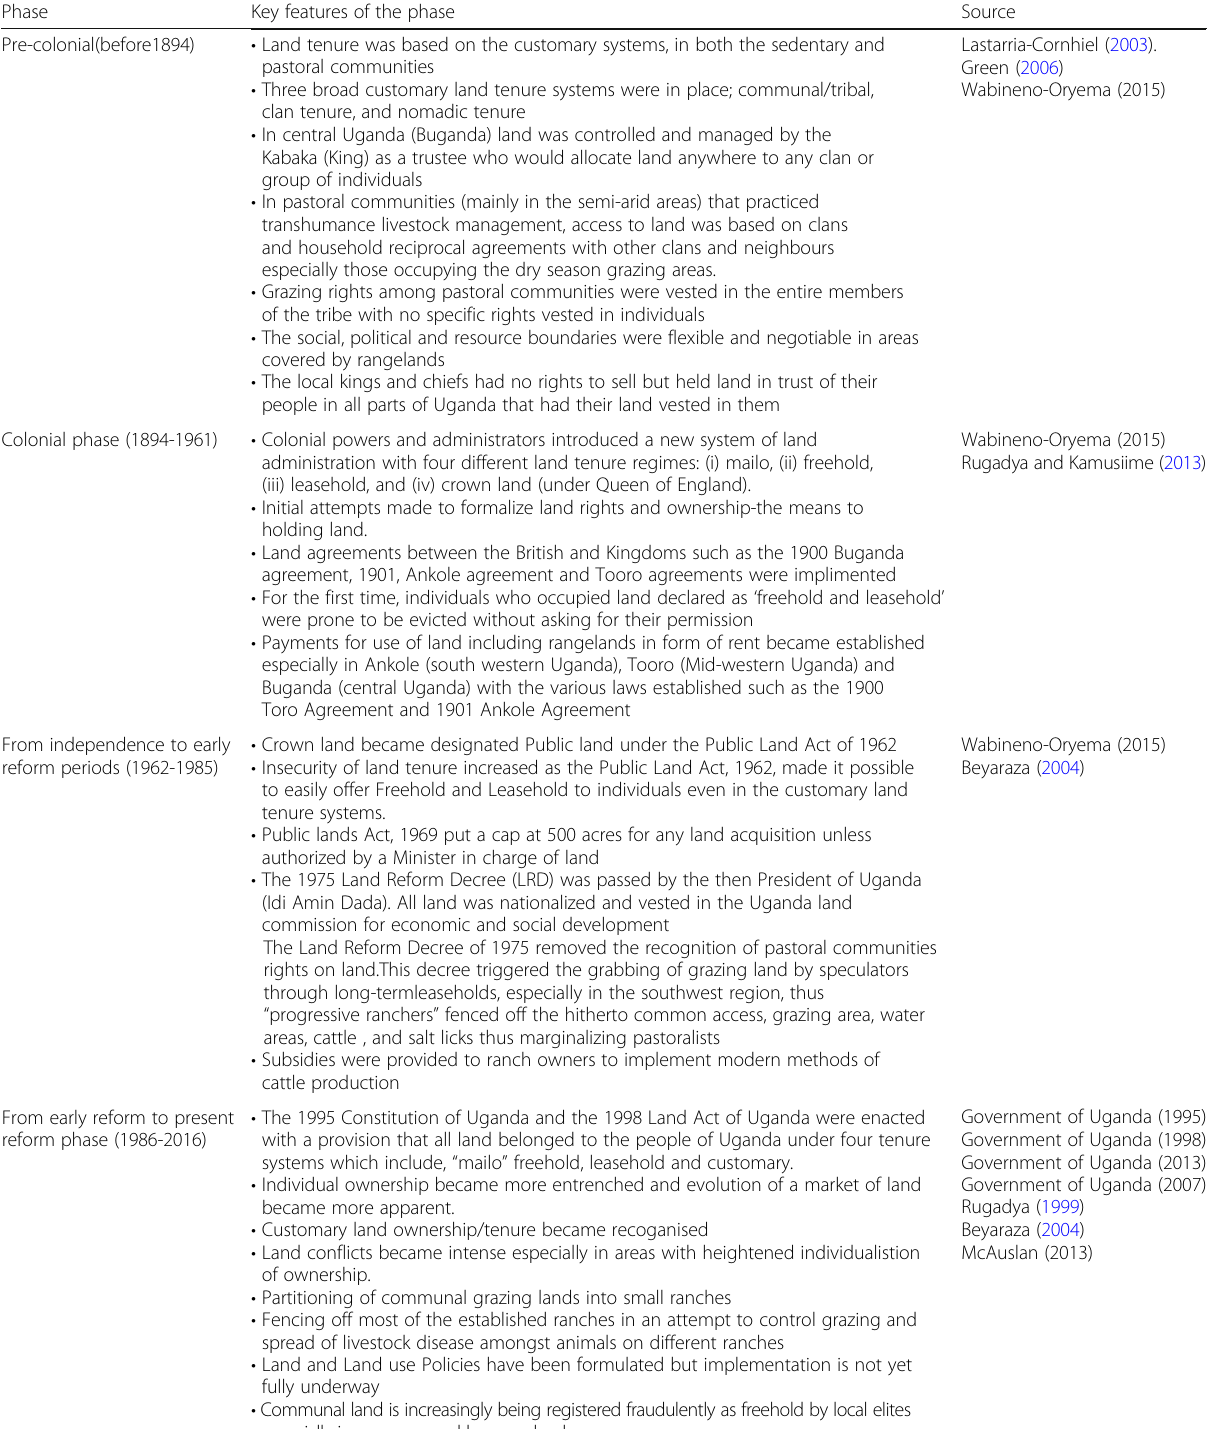
Table 1 Key phases in the evolution of land use policies and laws in Uganda Phase Key features of the phase Source